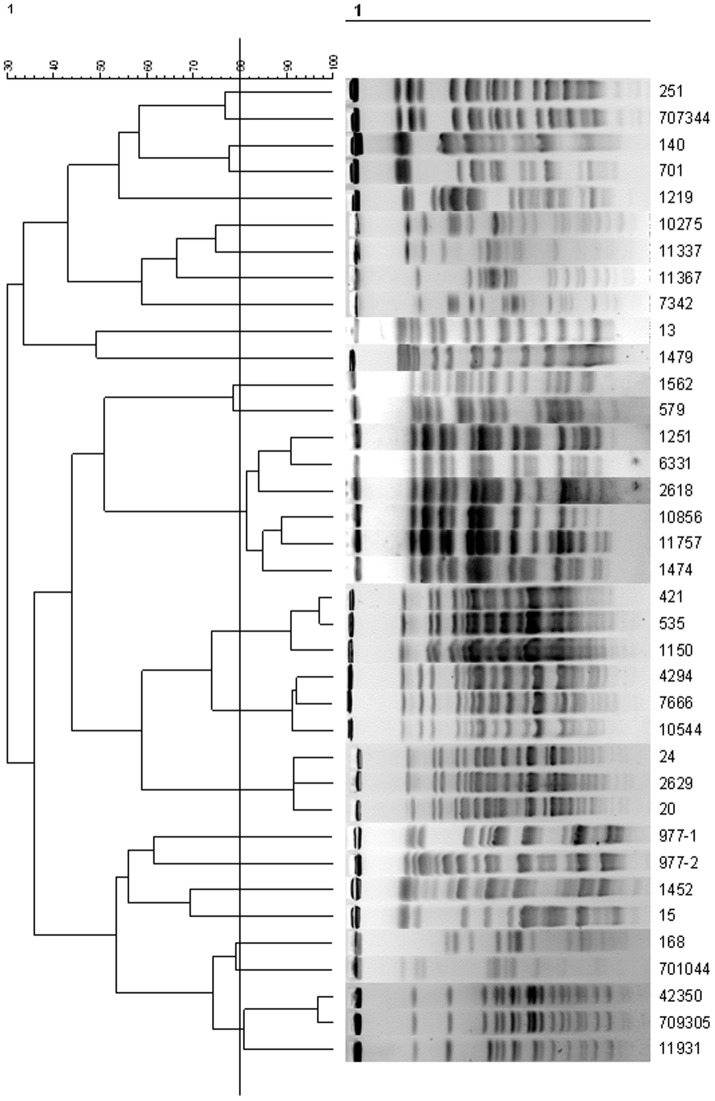
Dendrogram illustrating the percentage similarity of PFGE profiles in tested isolates of S. maltophilia.